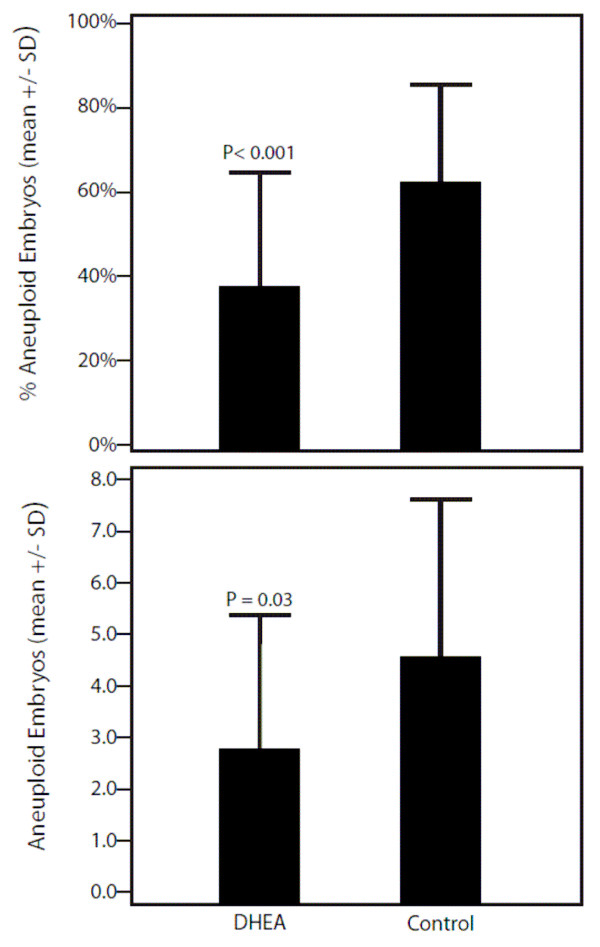
Comparison of absolute and percentages of aneuploidy in DHEA and control patients.